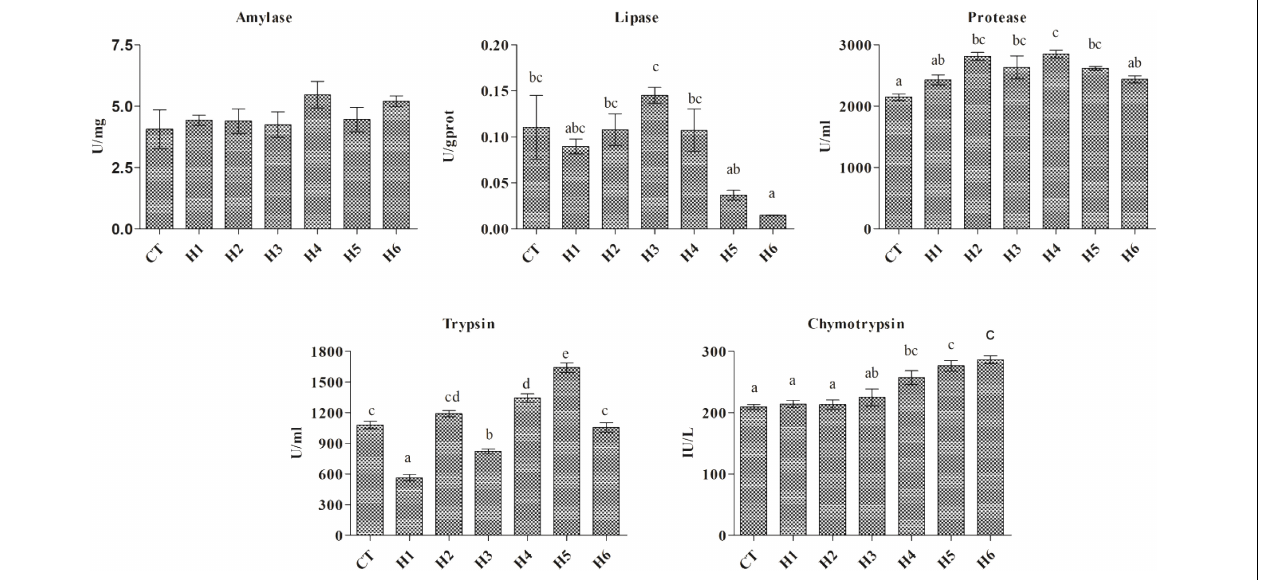
FIGURE 1 | Effect of HFP on digestive enzymes activity in the intestine of juvenile pearl gentian hybrid grouper. Data are presented as Means ± SE. Means without superscript do not differ significantly (P < 0.05), whiles those with superscript differ significantly (P < 0.05).